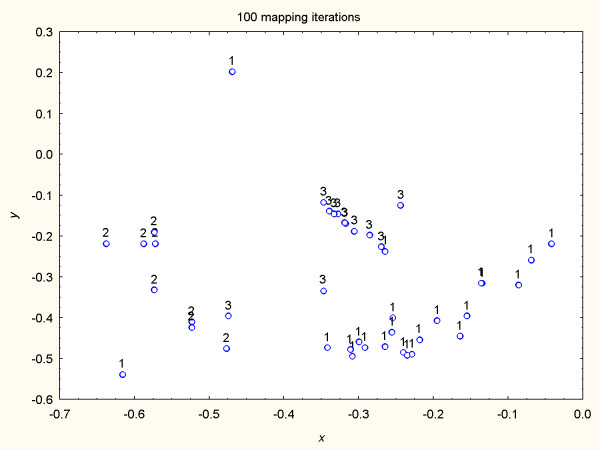
Resulting maps for the SRBCT data considering only 3 classes. EWS, RMS and BL samples are represented by symbols '1', '2', '3' respectively. 100 mapping iterations.